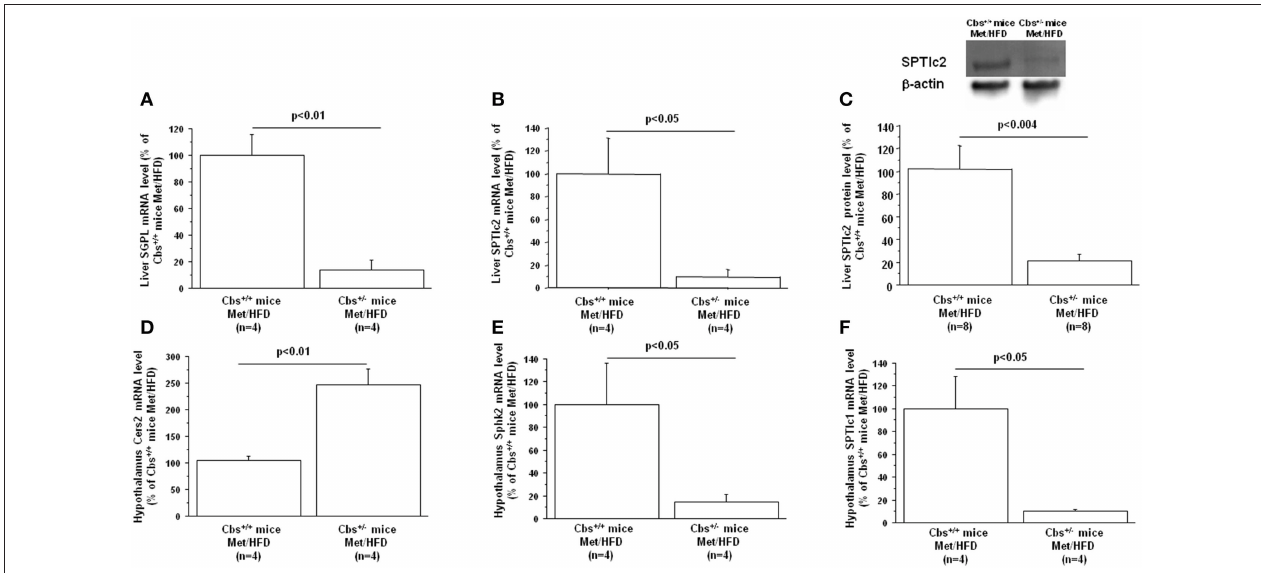
FIGURE 2 | Effect of hyperhomocysteinemia and high fat diet on liver (A) SGPL1 mRNA, (B) SPTlc2 mRNA, (C) SPTlc2 protein, (D) Cers2 hypothalamus mRNA, (E) Sphk2 hypothalamus mRNA, and (F) SPTlc1 hypothalamus mRNA level in wild type (Cbs + / + mice) and mice heterozygous for targeted disruption of the Cbs (Cbs + / − mice) on a methionine enriched diet (Met) and high fat diet (HFD). Relative liver and hypothalamus mRNA expression was described in Table 1 . Liver SPTlc2 was determined by western blot and quantified by slot blotting [1/1,000 (101)]. β -actin (1/10,000) (Sigma-Aldrich, France) was used as an internal control for Western blot analysis or ponceau-S coloration for slot blot analysis. Data are presented as mean ± SEM, and analyzed with the Student’s t -test by using Statview software. n , number of mice. Data were considered significant when p <